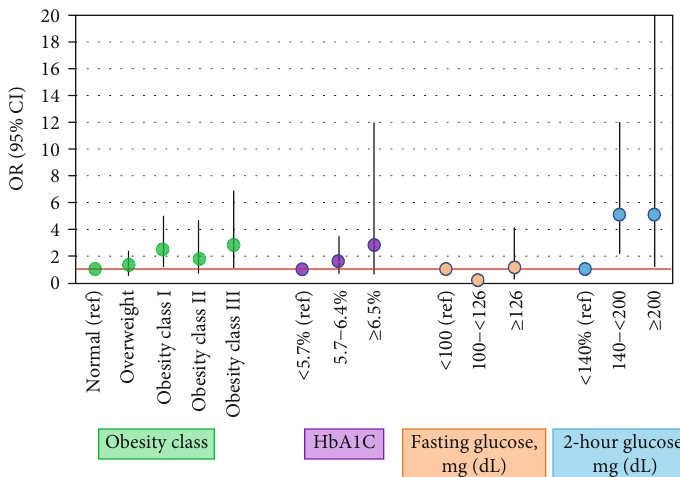
Figure 2: Odds ratios (95% con fi dence intervals) for adverse anthropometric and metabolic outcomes comparing o ff spring of mothers with pregestational diabetes (the TEAM Study) to age-, sex-, and race-matched NHANES 2015-2016